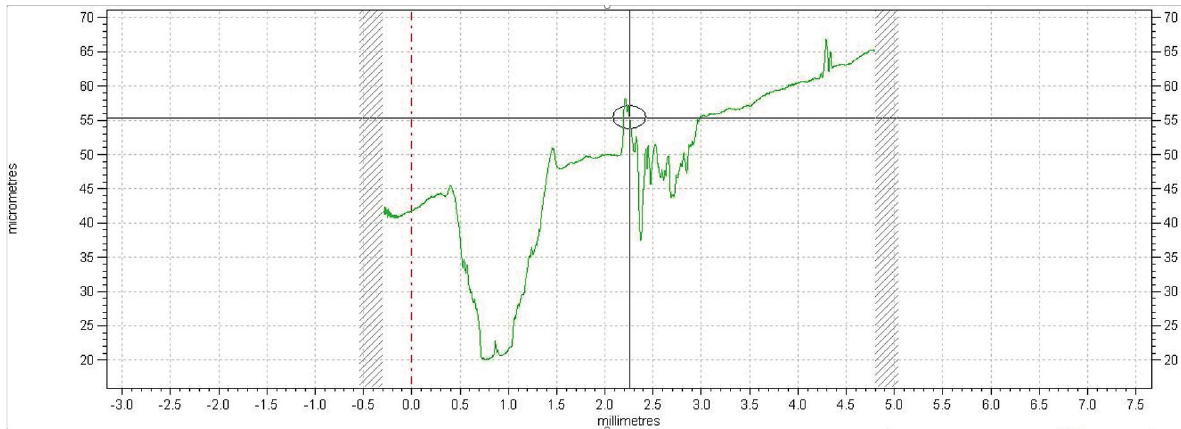
Figure 17. Wear profile tracks for the 10 N, 6 N, and 2 N